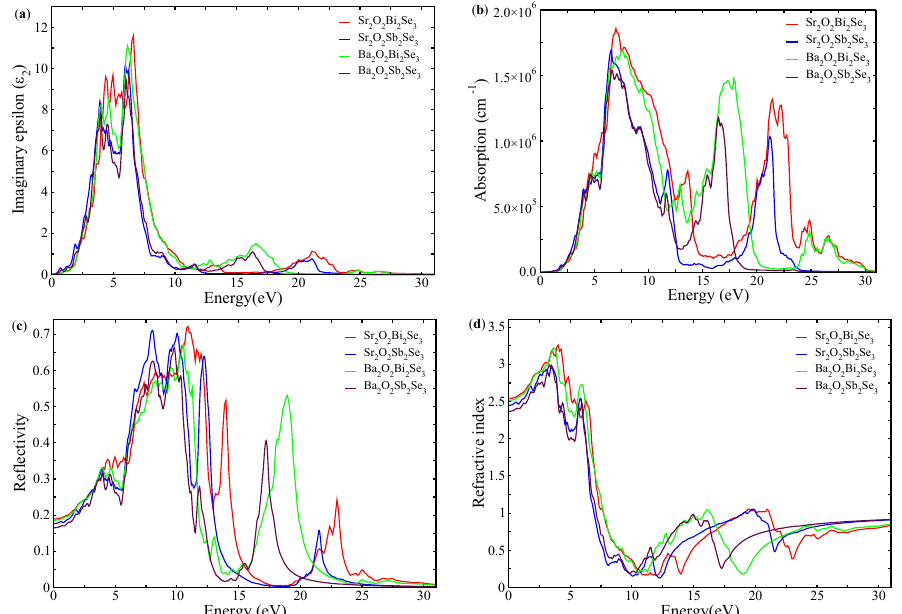
Figure 3. Optical spectrum of A 2 O 2 B 2 Se 3 (A = Sr, Ba; B = Bi, Sb) compounds for E (cid:107) a. ( a ) Imaginary part of the dielectric function, ( b ) absorption coefficient, ( c ) reflection spectra, and ( d ) refractive index. The absorption coefficient defines the region where a material absorbs energy. The energy dependence of the absorption spectrum of the present compounds for E (cid:107) a is given in Figure 3b. The absorption edge is away from 0 eV, which corresponds to the energy gaps. The absorption coefficient exhibits two prominent peaks indicating that they could absorb visible light. The first peaks of Sr 2 O 2 Bi 2 Se 3 and Ba 2 O 2 Bi 2 Se 3 are present in the same region at around 3 eV and extend to 12 eV, the second peaks are located at 16 eV and 24 eV for Ba 2 O 2 Bi 2 Se 3 and Sr 2 O 2 Bi 2 Se 3 , respectively. For Sr 2 O 2 Sb 2 Se 3 and Ba 2 O 2 Sb 2 Se 3 , the same trend is found but in a different region of adsorption. Notably, they exhibited two prominent